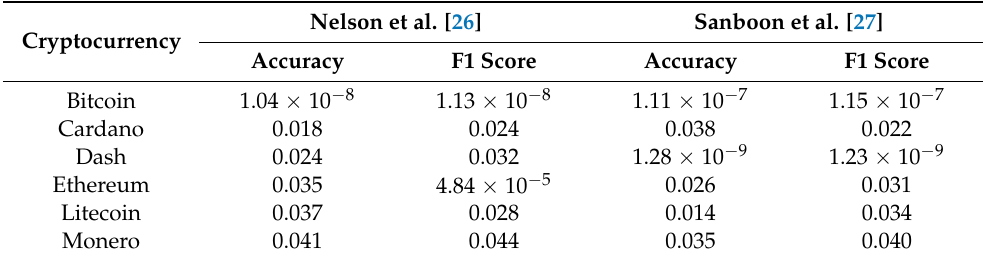
Table 7. Value of the F -test in each cryptocurrency’s accuracy and the F1 score. Nelson et al. [26] Cryptocurrency